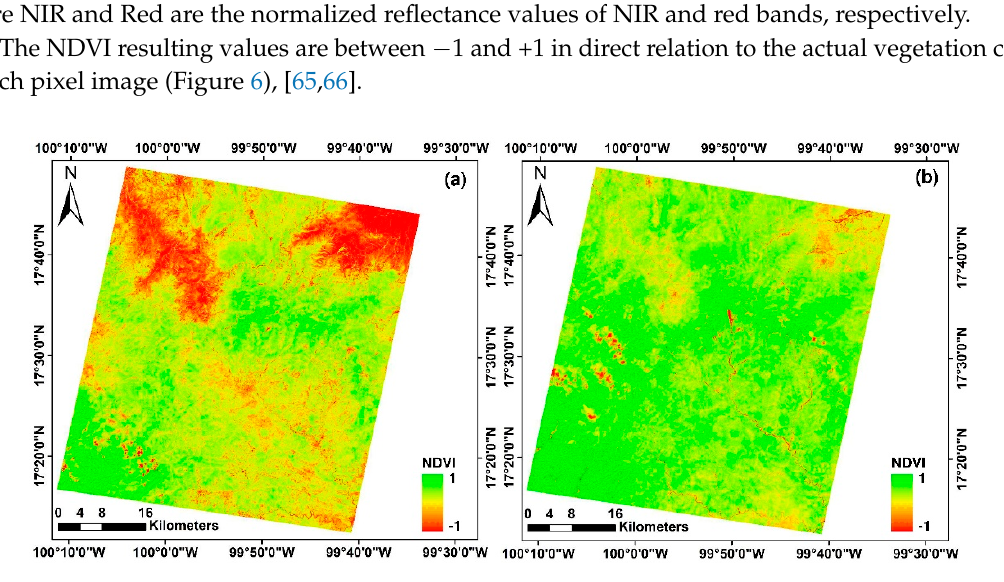
Figure 6. NDVI images of ( a ) 10 December 2012 and ( b ) 13 December 2013.